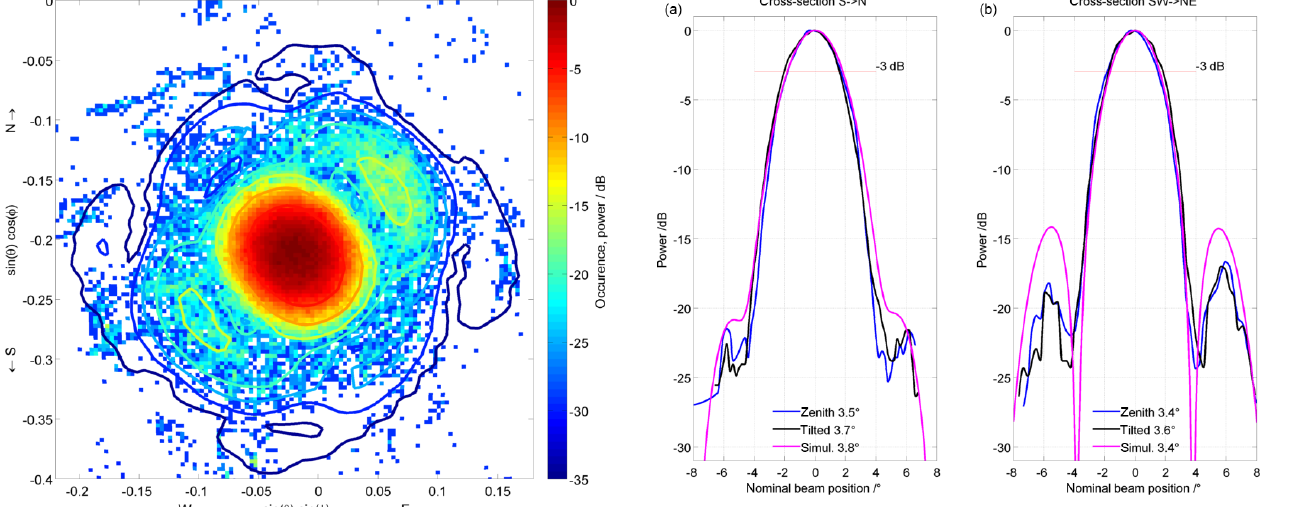
Figure 5. Angular occurrence rate for the tilted beam ( φ = 185 ◦ , θ = 12 . 4 ◦ ) overlaid by the simulated radiation pattern for January 2014 when about 20% of the antenna array was non-functional.